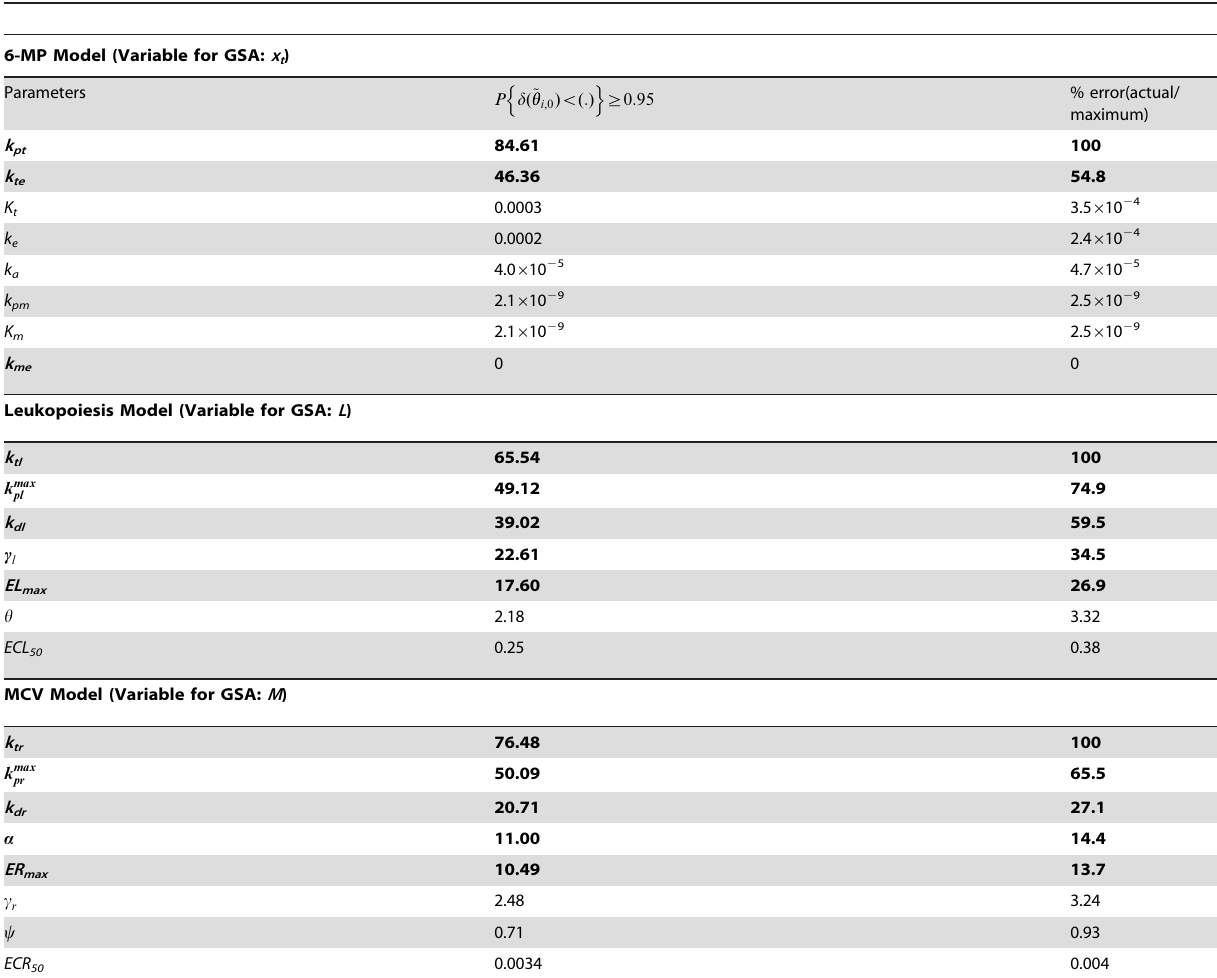
Table 4. List of parameters identified for individualization through GSA (in bold letters) together with other fixed parameters.